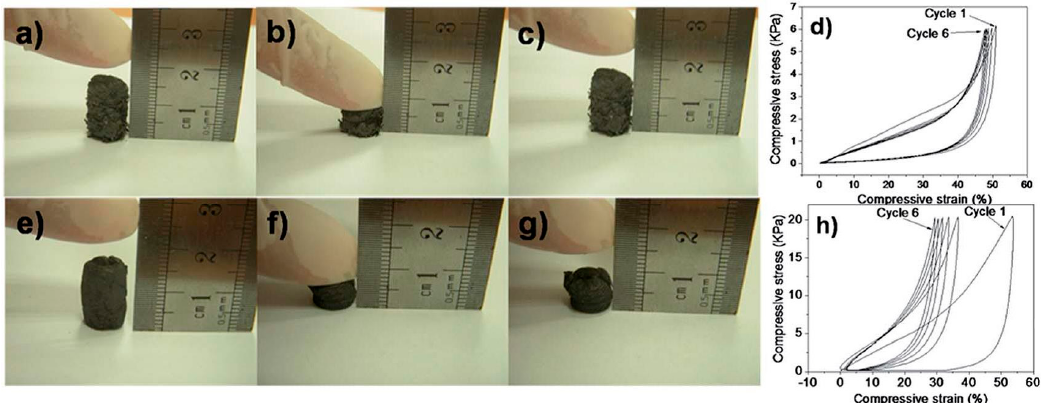
Figure 9. Mechanical properties of graphene sponges (GS) and graphene foams (GF). Compression-recovery process of GS ( a – c ) and GF ( e – g ) after 50% deformation, and the compressive stress-strain curves of 6 cycles of loading and unloading for GS ( d ) and GF ( h ) under constant pressure. Adapted from [3], with permission from © 2014 The Royal Society of Chemistry.